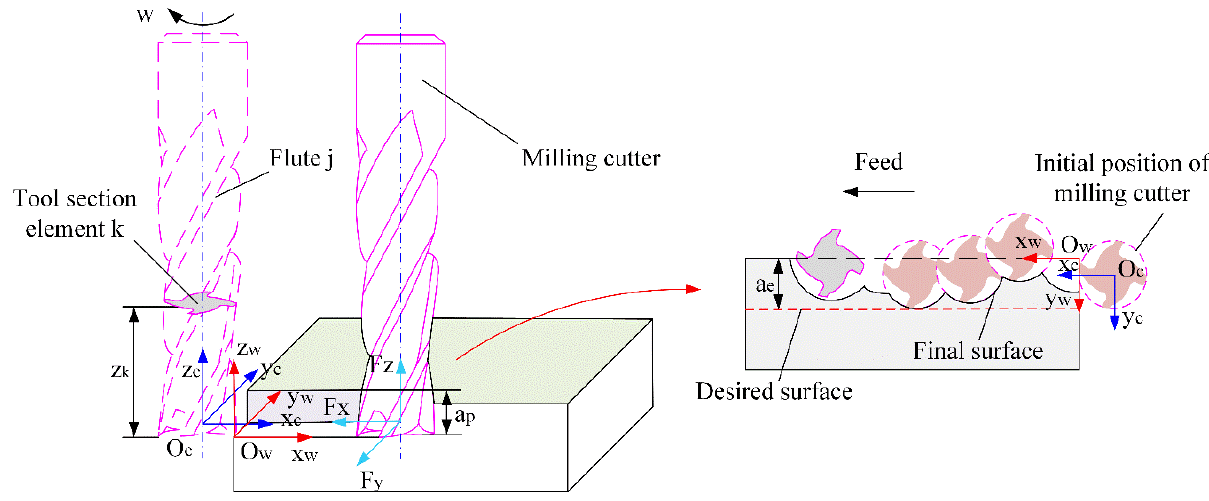
Figure 24. The creation of surface topography.